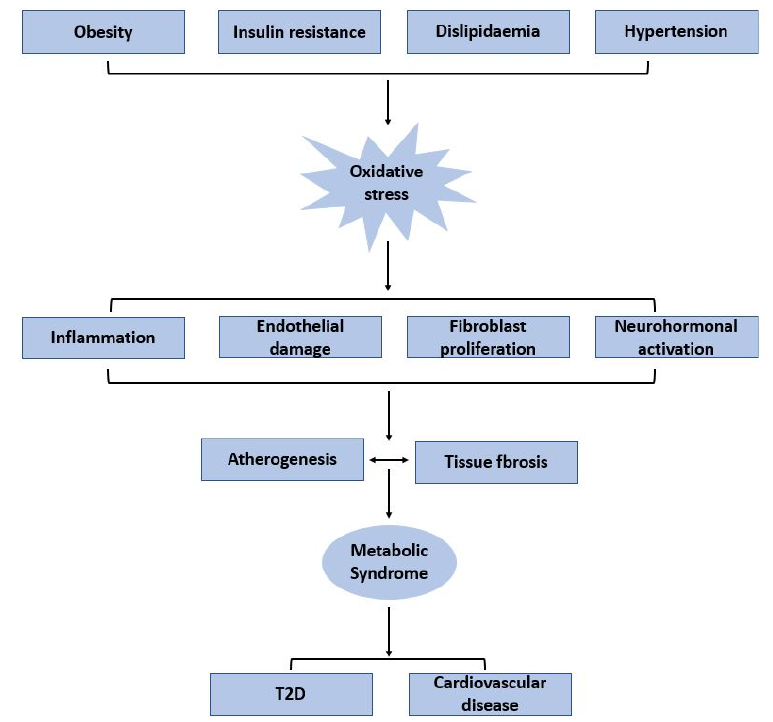
Figure 1. Key players in the pathogenesis and complications of metabolic syndrome.